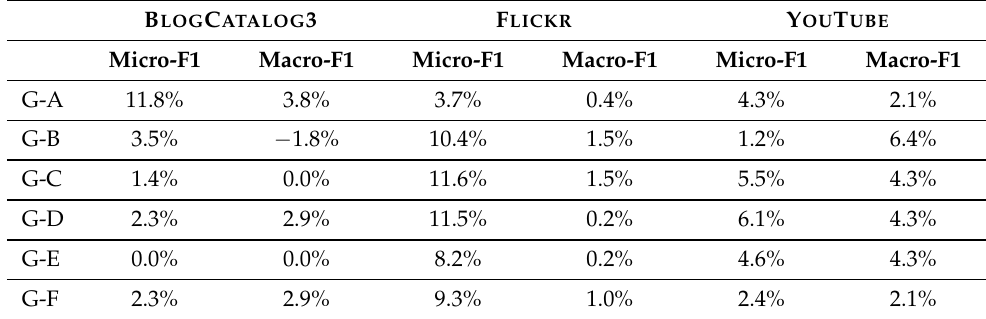
Table 5. Performance comparisons of SORAG F with different training procedures.